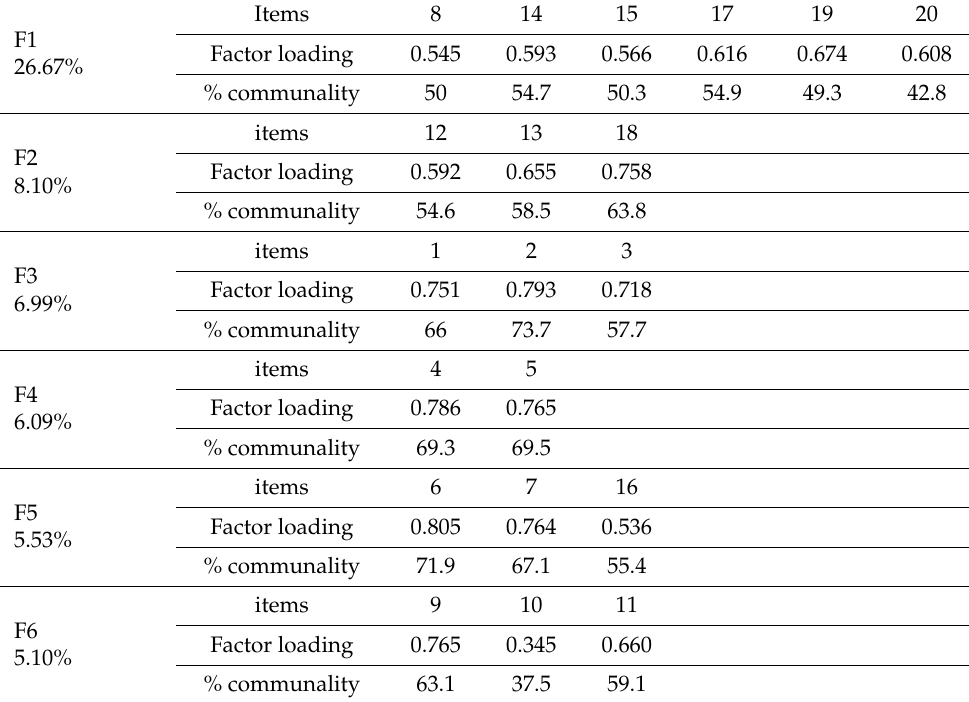
Table 5. Components of each factor in the factorial structure of CM.